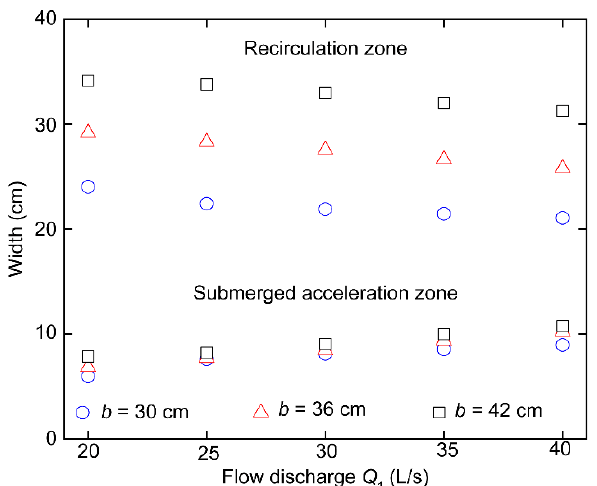
Figure 6. Relationships between the width of the recirculation zone, flow discharge, and rectangular channel width.